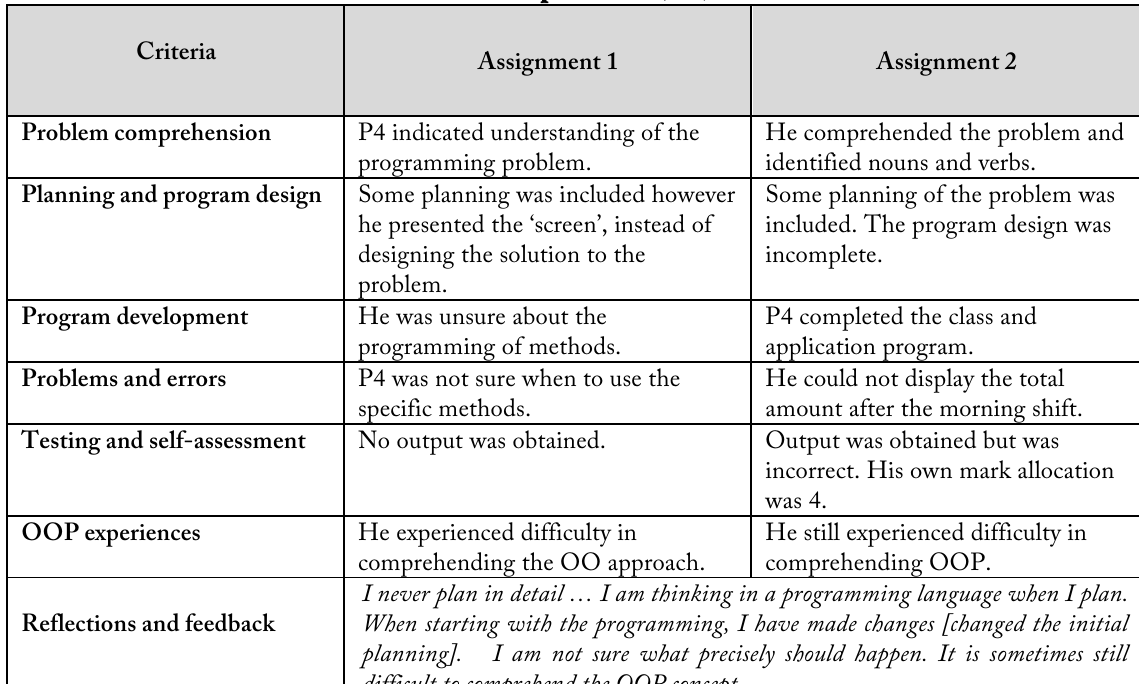
Table 5: Participant 4’s (P4)